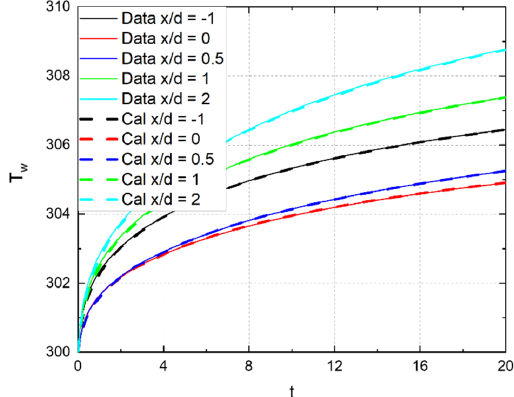
Figure 3. Comparison of wall temperature between the data and calculation with different x/d and t at y/d = 4 for case 2.